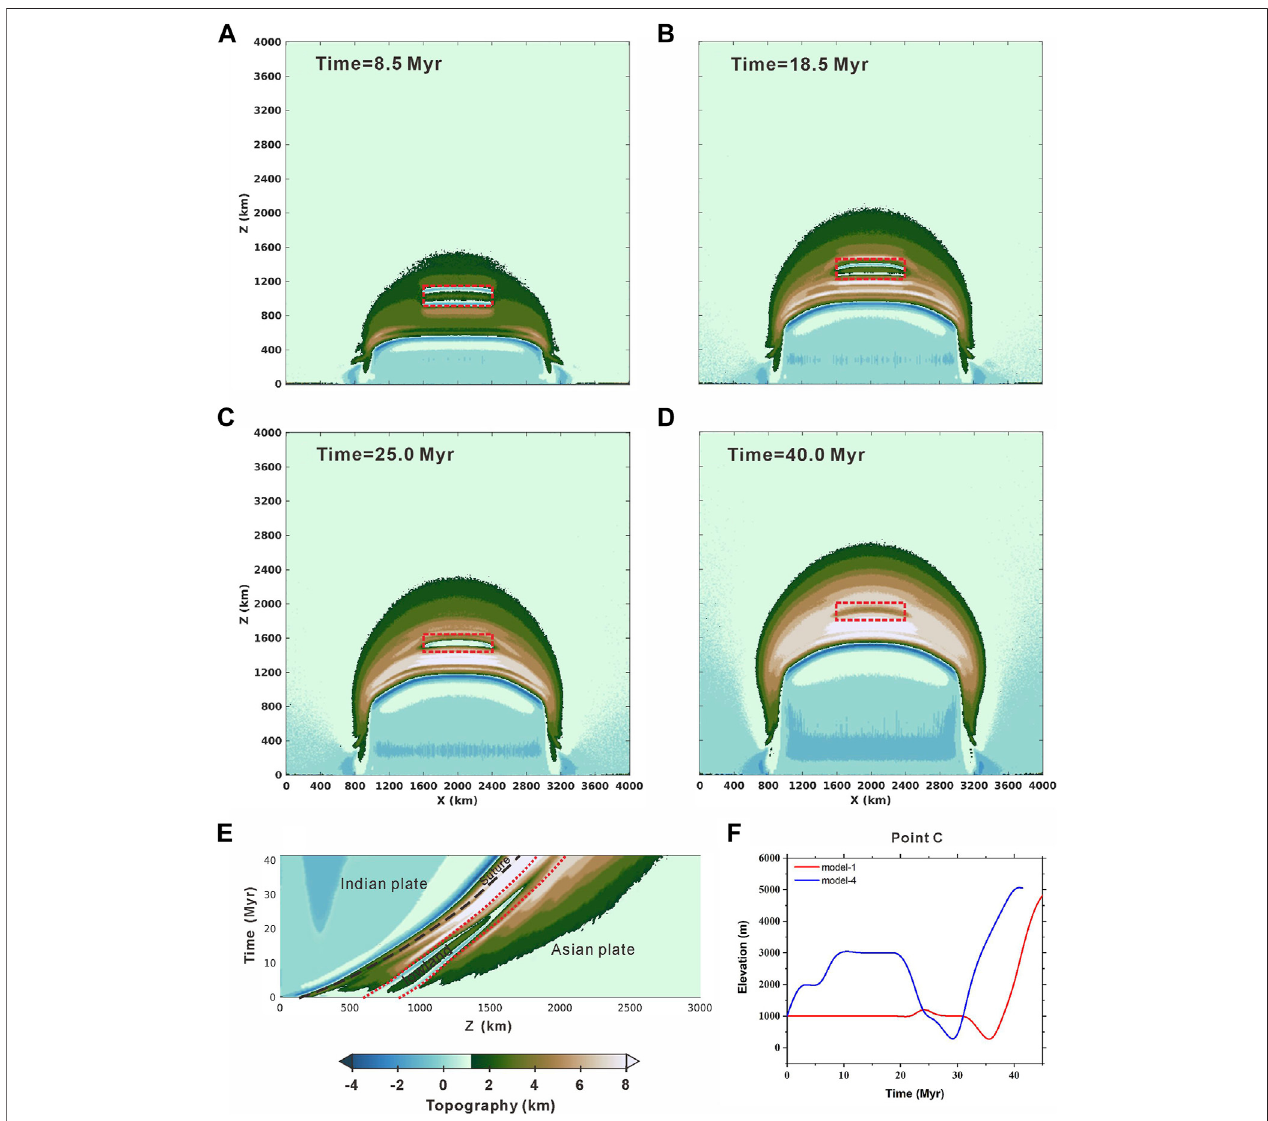
FIGURE 8 | Topographic evolution of the model-4 ( Table 2 ). Snapshots showing the surface topography at (A) 8.5 Myr (B) 18.5 Myr (C) 25.0 Myr, and (D) 40.0 Myr (E) exhibitthetopographicevolutionwithtimealongsectionx=2,000 km (F) showingthedifferenceoftheuplifthistoryofcenterpointCbetweenthereference model (red curve) and model-4 (blue